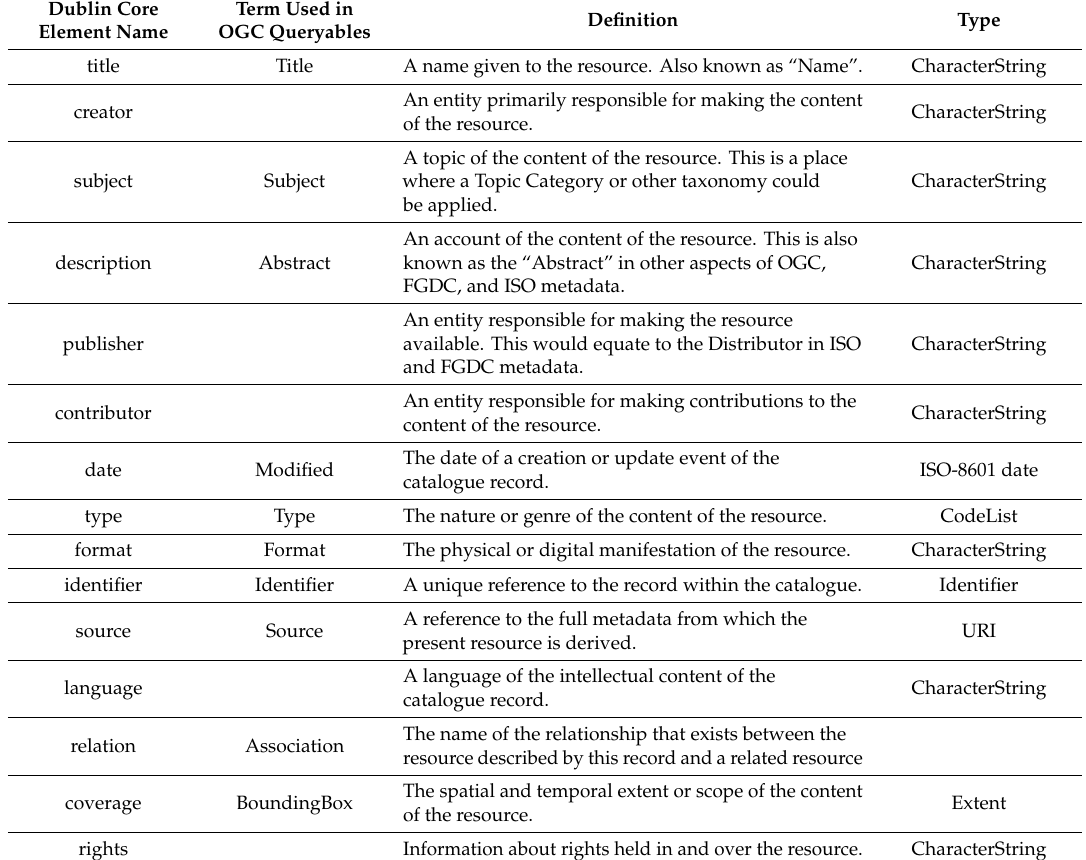
Table 13. OGC CSW Core